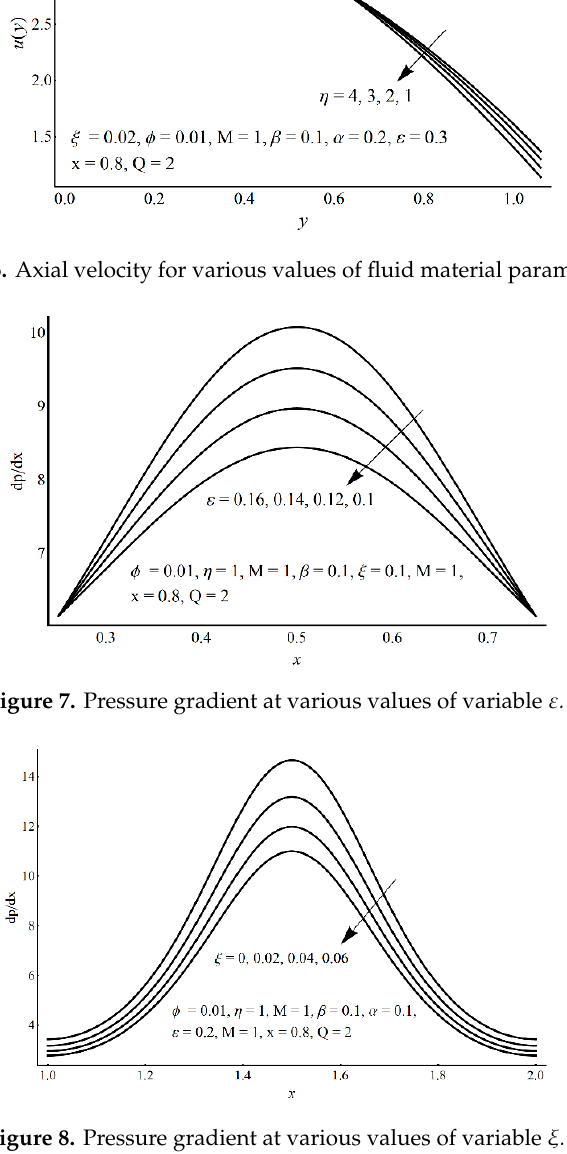
Figure 9. Pressure gradient at various values of variable η .